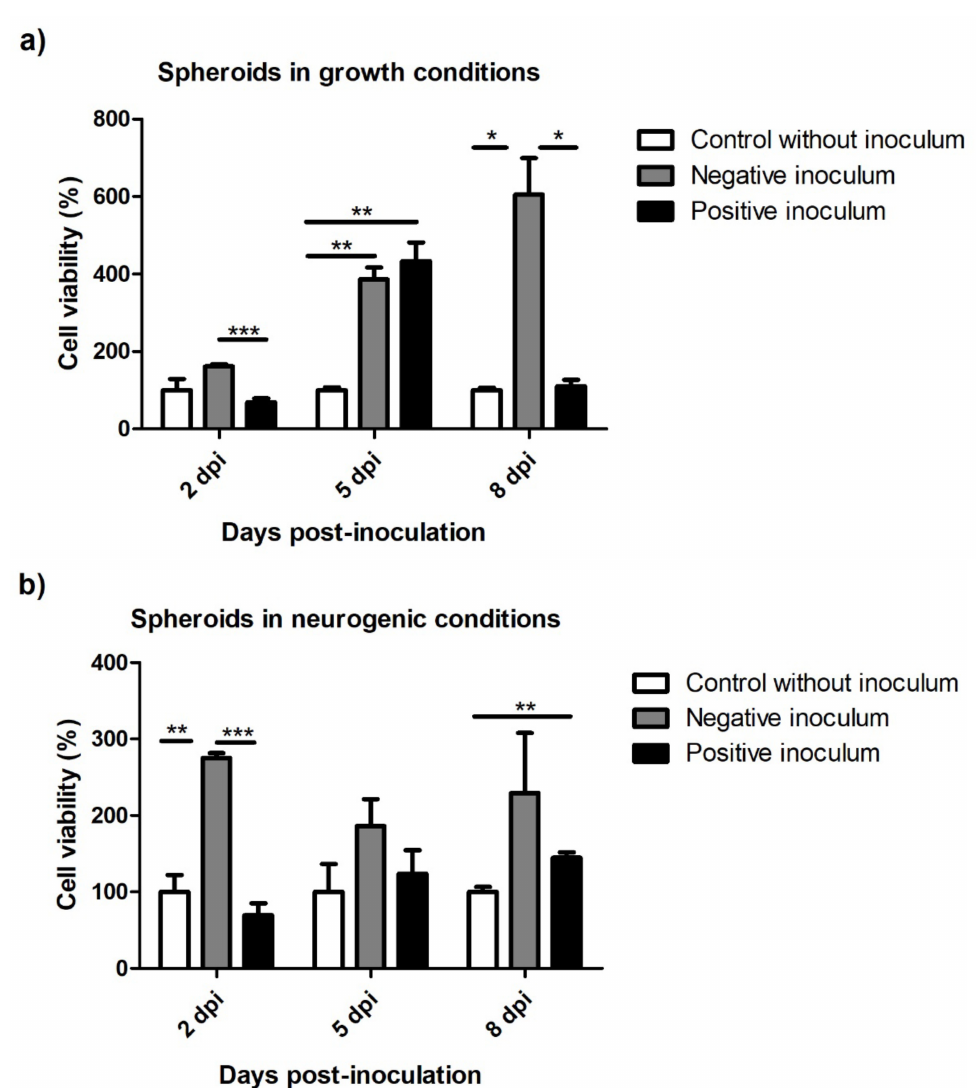
Figure 10. Cell viability of spheroids in growth ( a ) and neurogenic ( b ) conditions 2, 5, and 8 days post-inoculation. The viability values are presented as percentages (%), considering the viability of the controls without inocula as 100% for each infection time. Data are shown as mean values ± SEM. * p < 0.05; ** p < 0.01; *** p <